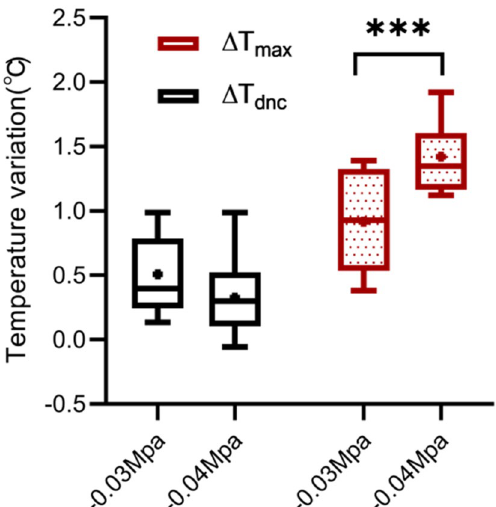
Figure 9. Comparison between ∆T dnc and ∆T max in the two negative pressure groups. The dot represents the mean, and the horizontal lines in the boxplot represent, from bottom to top, the minimum, first quartile, median, third quartile, and maximum. *** P <